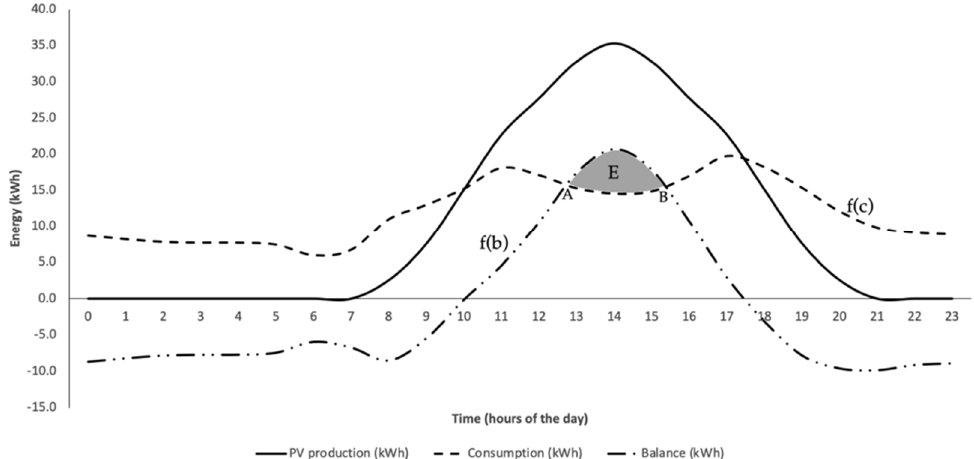
Figure 10. Schematic representation of the relationships between the different variables of the system, where f ( c ) is the representative function of energy consumption over time, f ( b ) is the representative function of the balance between PV energy production and energy consumption over time, and E represents the total amount of surplus energy. A and B are the interception points between f(b) and f(c) .